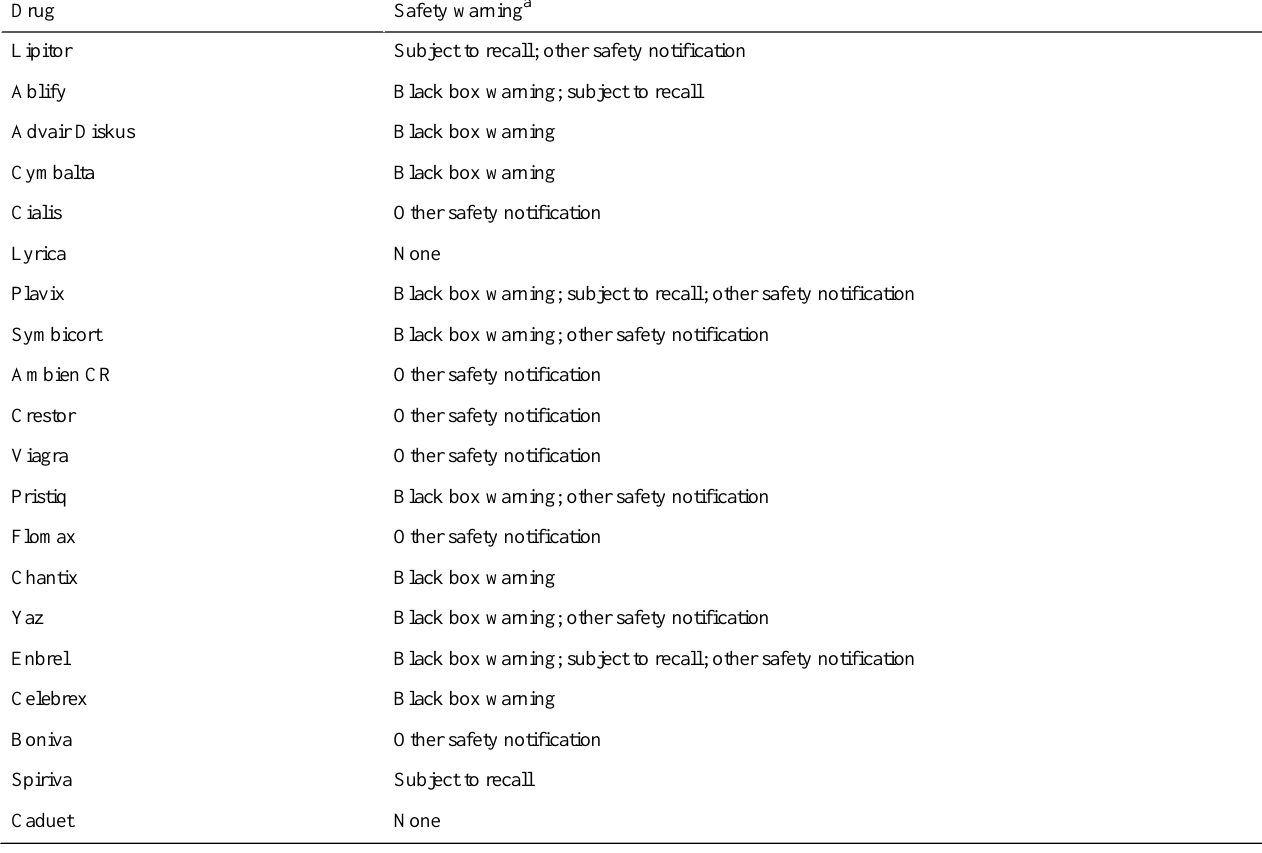
Safety warning a